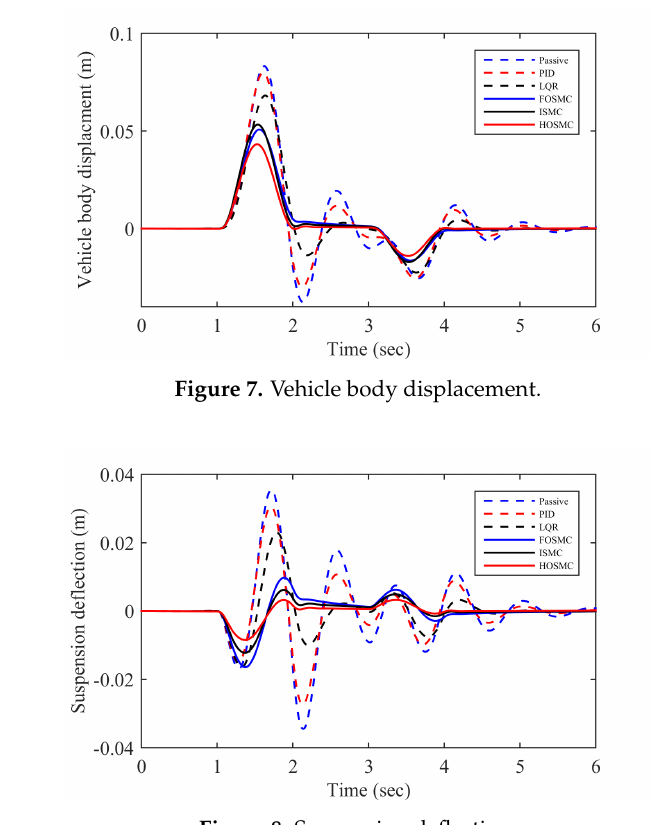
Figure 8. Suspension